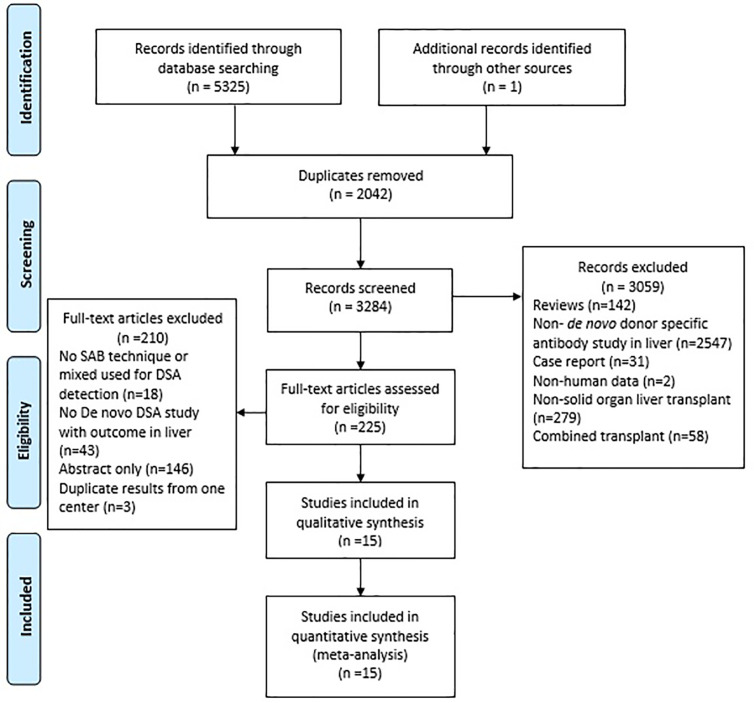
The flow diagram of the study selection for the systematic review.